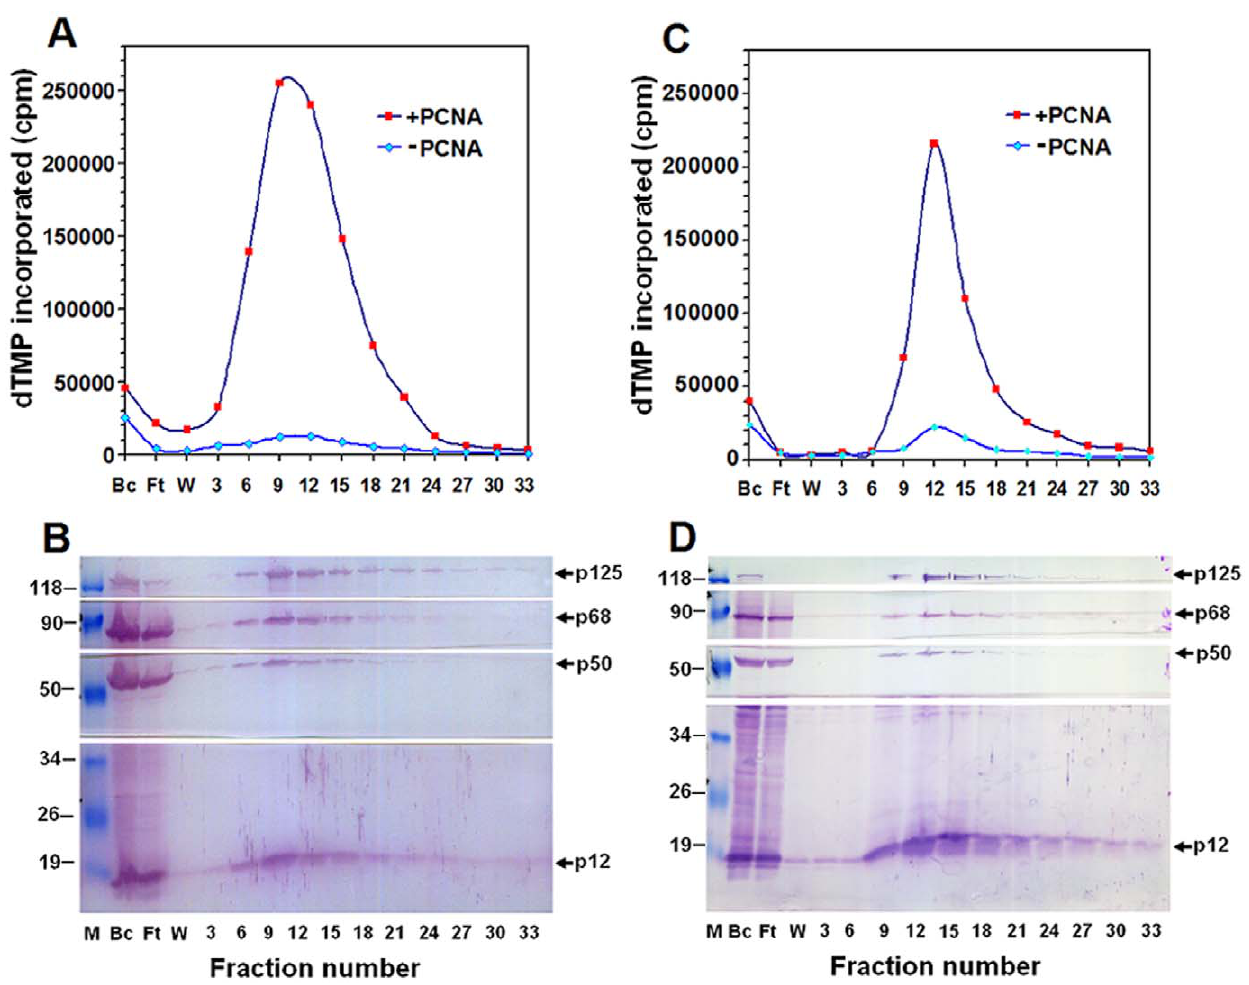
Figure 4. Purification of recombinant human pol d heterotetramer by immunoaffinity chromatography. Infected larval hemolymph was centrifuged and divided into supernatant and pellet fractions. The supernatant fraction was subjected to immunoaffinity column. The lysates (BC), flow-through (FT), wash (W), and eluted fractions were assayed for DNA polymerase activity in the presence (square) and absence (diamond) of PCNA (panel A), and analyzed by 12.5% SDS-PAGE followed by Western blotting (panel B) using the antibodies specific for the individual subunit as described under ‘‘Materials and Methods’’. A parallel purification for the pellet fraction was also performed. The activities were assayed (panel C) and Western blotting analysis was carried out (panel